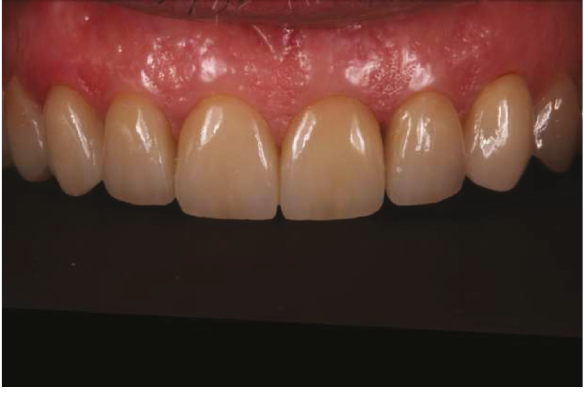
Figure 15: Intraoral maxillary view after 48